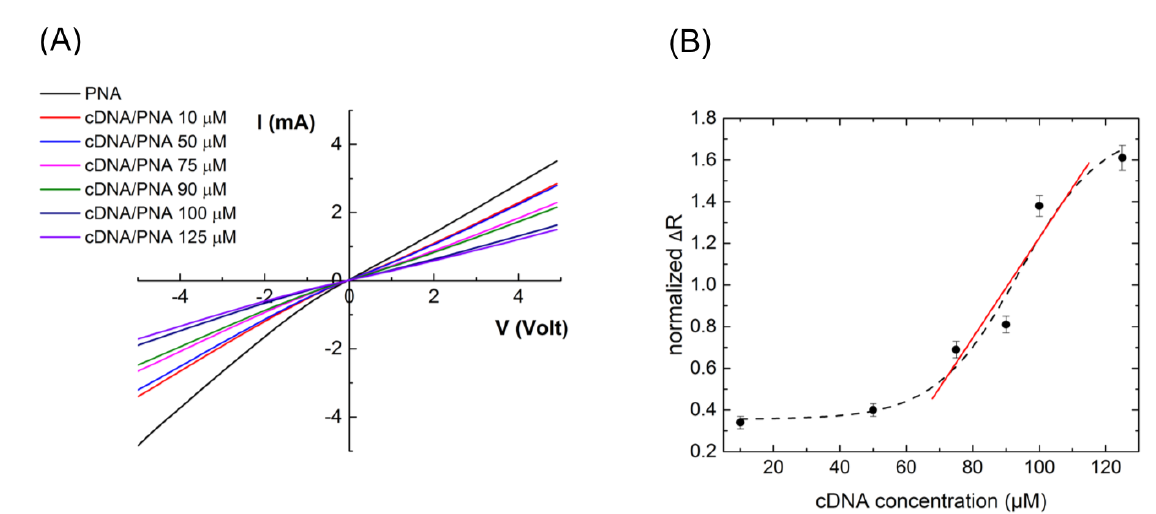
Figure 7. ( A ) I–V characteristics of ZnONW-based electrical transducer functionalized with 100 uM PNA probe, before and after interaction with increasing concentrations of cDNA in the 10 to 125 µM range. ( B ) Normalized ∆ R vs. cDNA concentration. Data were fitted using a dose-response model (black dash curve); data included between 75 and 100 µM were fitted by a linear model (red curve).